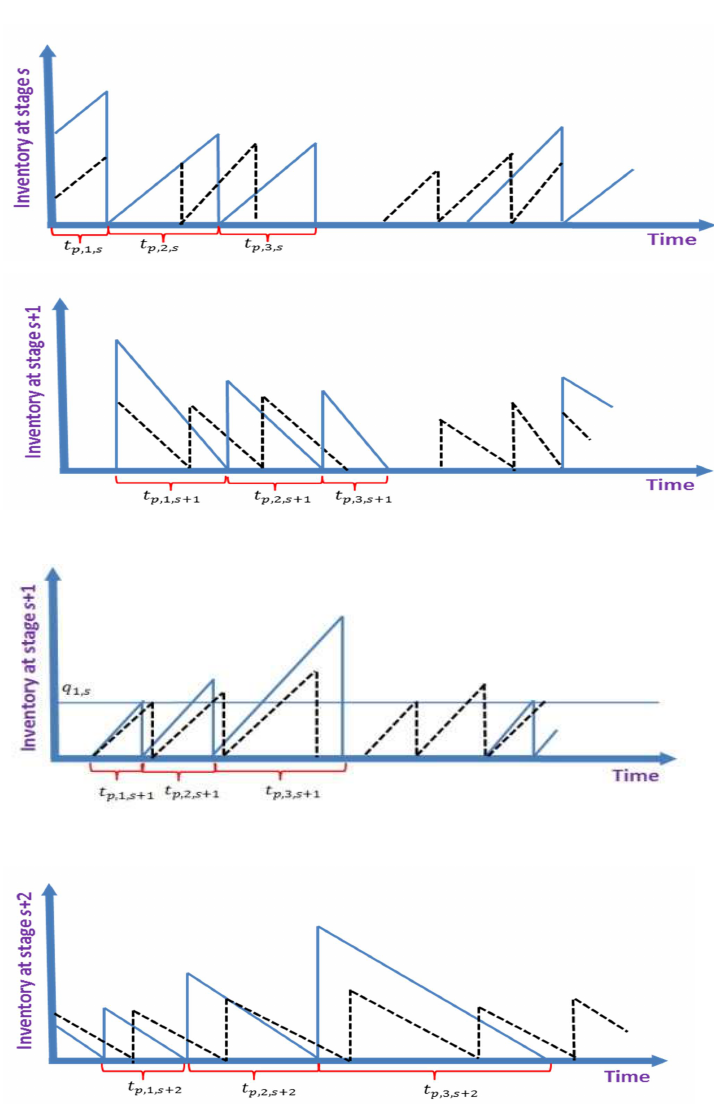
Figure 2. Inventory versus time plots for unequally sized batch